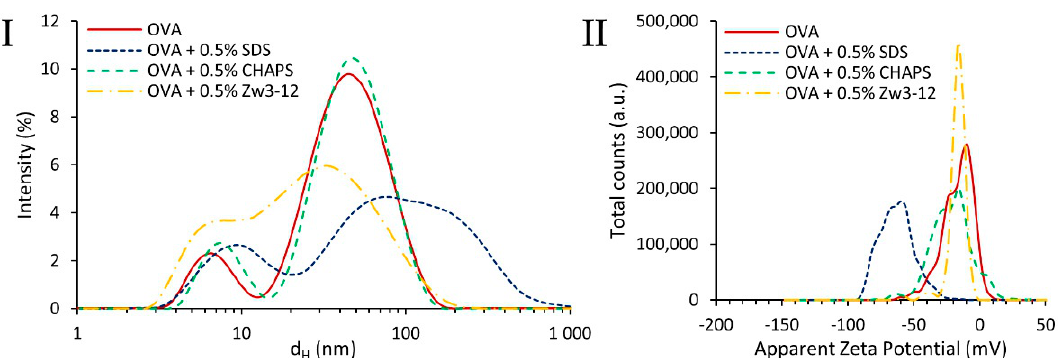
Figure 9. Intensity particle size distribution (PSD) of 40 µ M OVA (solid red line) in the presence and absence of 0.5 wt% of surfactants (dashed lines) in 10 mM phosphate buffer at pH 7.4 ( I ), resulting in particles with different hydrodynamic diameter (d H ), and the apparent zeta potential ( ζ ) for the same solutions ( II ).